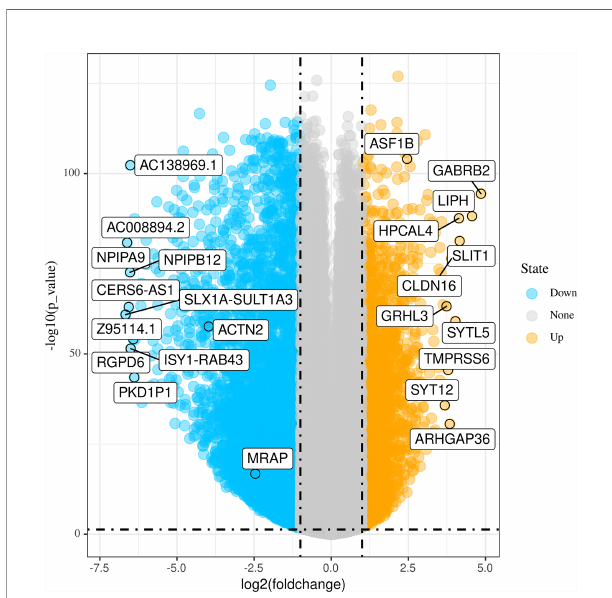
FIGURE 2 | Volcano plots of differentially expressed genes (DEGs) between tumor tissues and normal